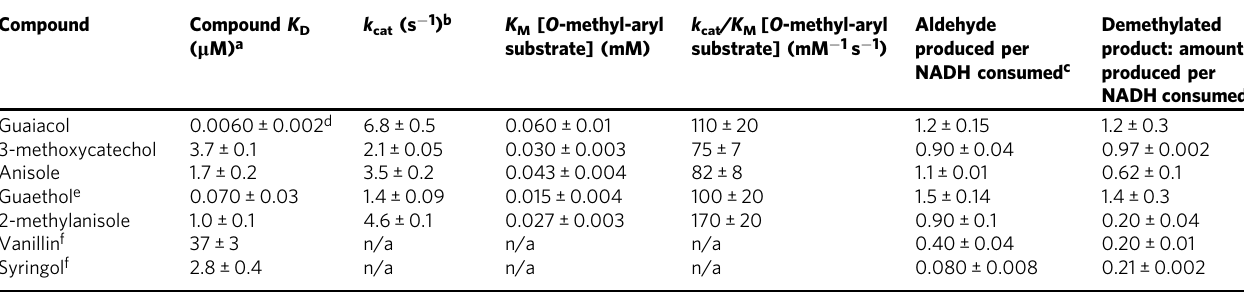
Table 1 Ef fi ciency of GcoAB toward binding and demethylation of O -methyl-aromatic compounds